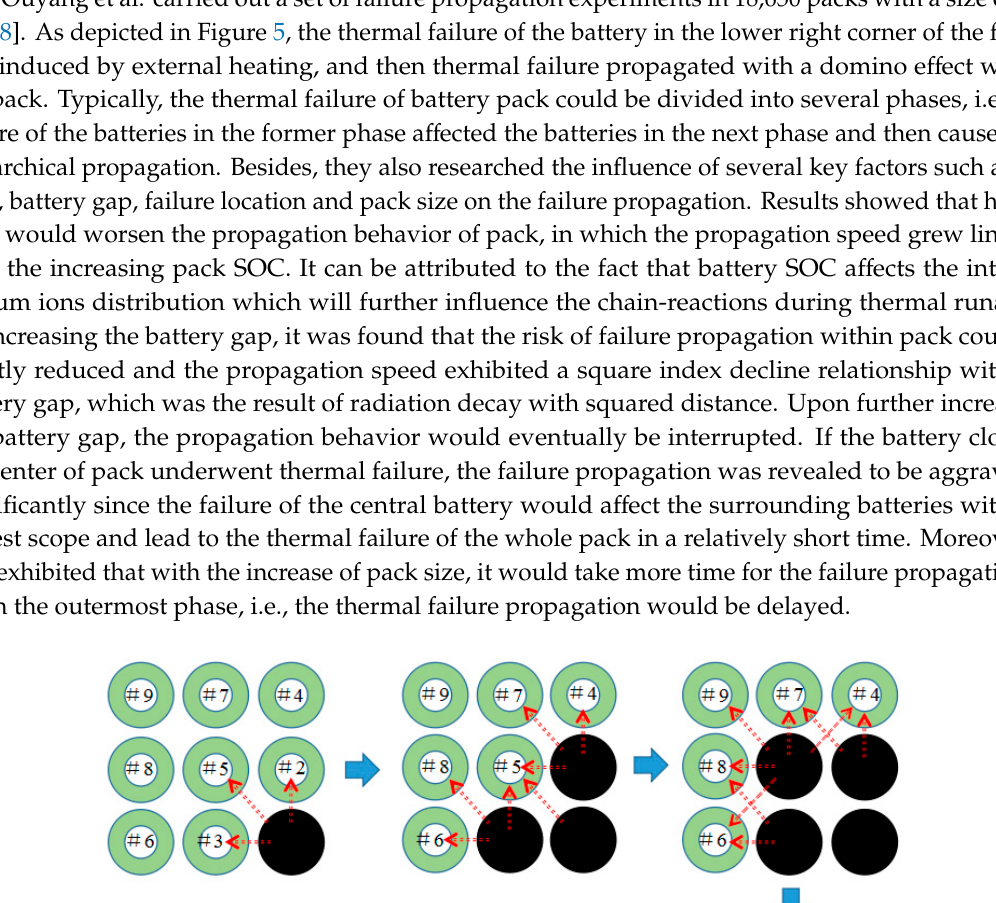
Figure 6. The propagation speeds of packs with various shapes where the numbering 1, 2, 3, 4, 5, and 6 represents the triangle pack, rectangle pack, parallelogram pack, line pack, hexagon pack and square pack respectively.